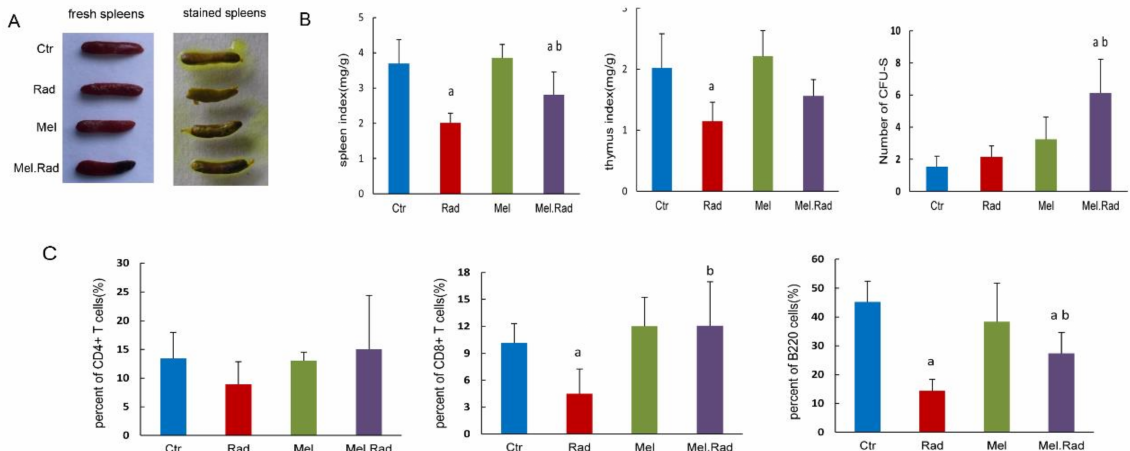
Figure 7. Effects of melatonin treatment on the immune system of mice following ABI. Mice were treated with melatonin (10 mg/kg) daily for 5 consecutive days by intraperitoneal injection before exposure to a dose of 14 Gy ABI. A group of sham-irradiated control mice was regarded as a control. Spleen, thymus, and whole blood of mice were harvested at 3 days following radiation. ( A ) Representative images of the spleens. ( B ) The spleen/thymus coefficient and CFU-S per spleen were counted. ( C ) CD4 + T cells, CD8 + T cells, and B cells in blood were analyzed. Data are represented as mean ± SD, n = 6 mice/group. a p < 0.05 vs. Ctr; b p < 0.05 vs.